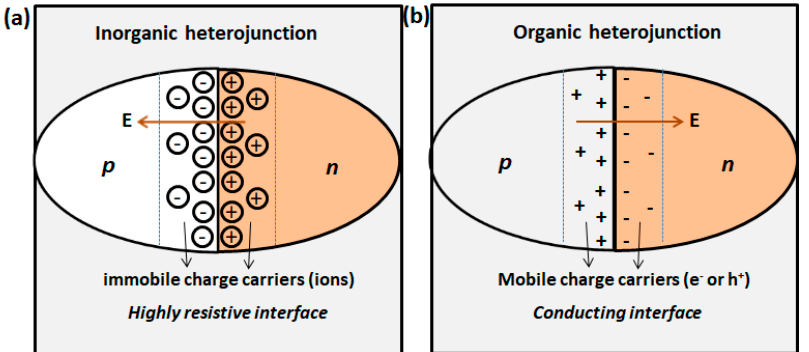
Figure 1. Typical p-n heterojunction formation and interfacial charges alignments in conventional inorganic semiconductor ( a ) and organic semiconductor ( b ). (adapted from [18]). The arrangements of mobile (e - or h + ) and immobile (ions) charges at the interface and associated direction of electric field are shown.